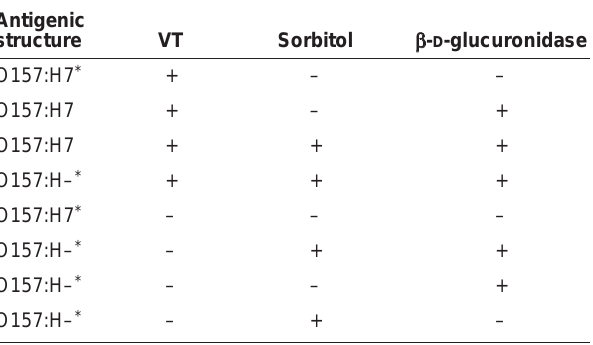
TABLE 1 Phenotypic profiles of Escherichia coli